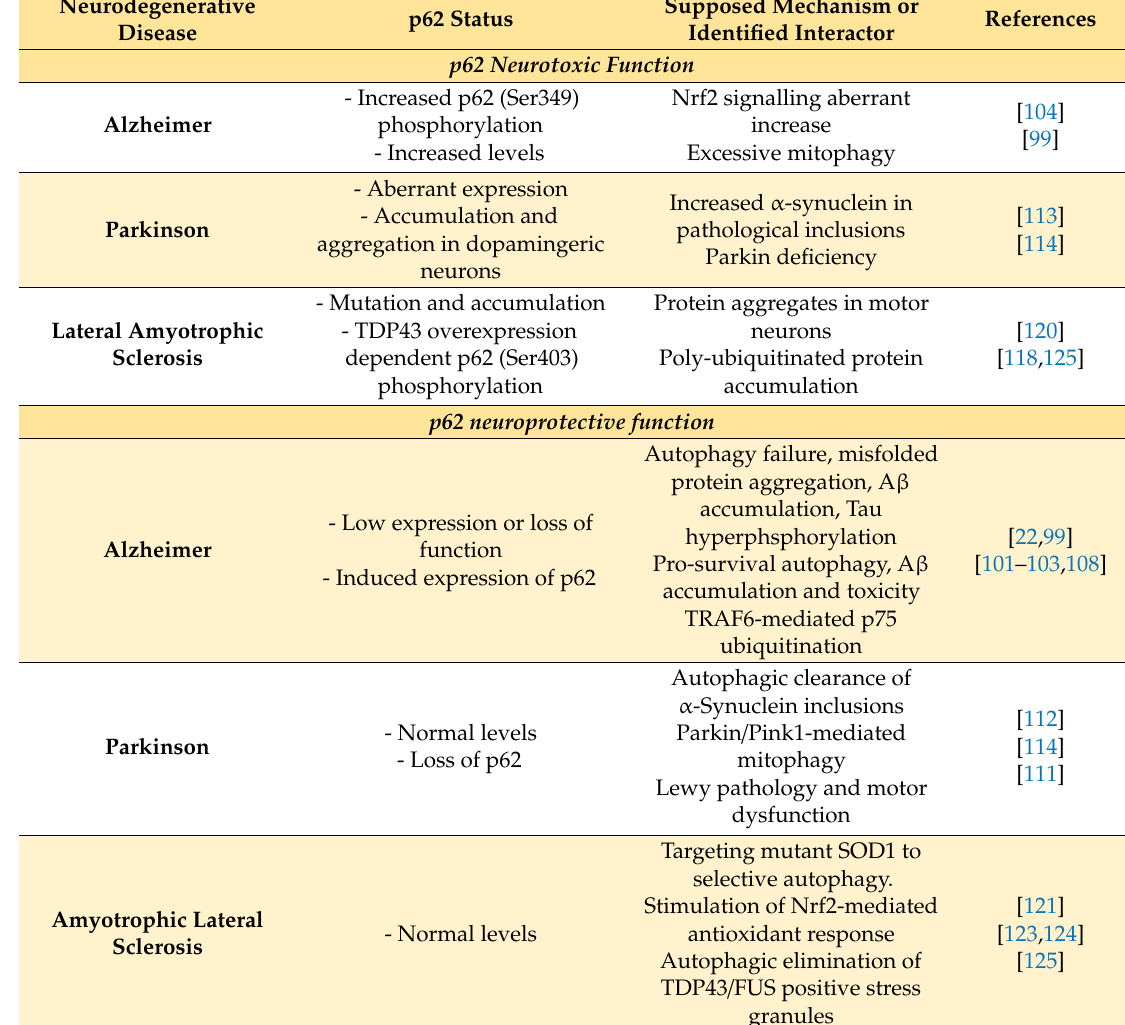
Table 2. Highlights of research findings of p62 double role in